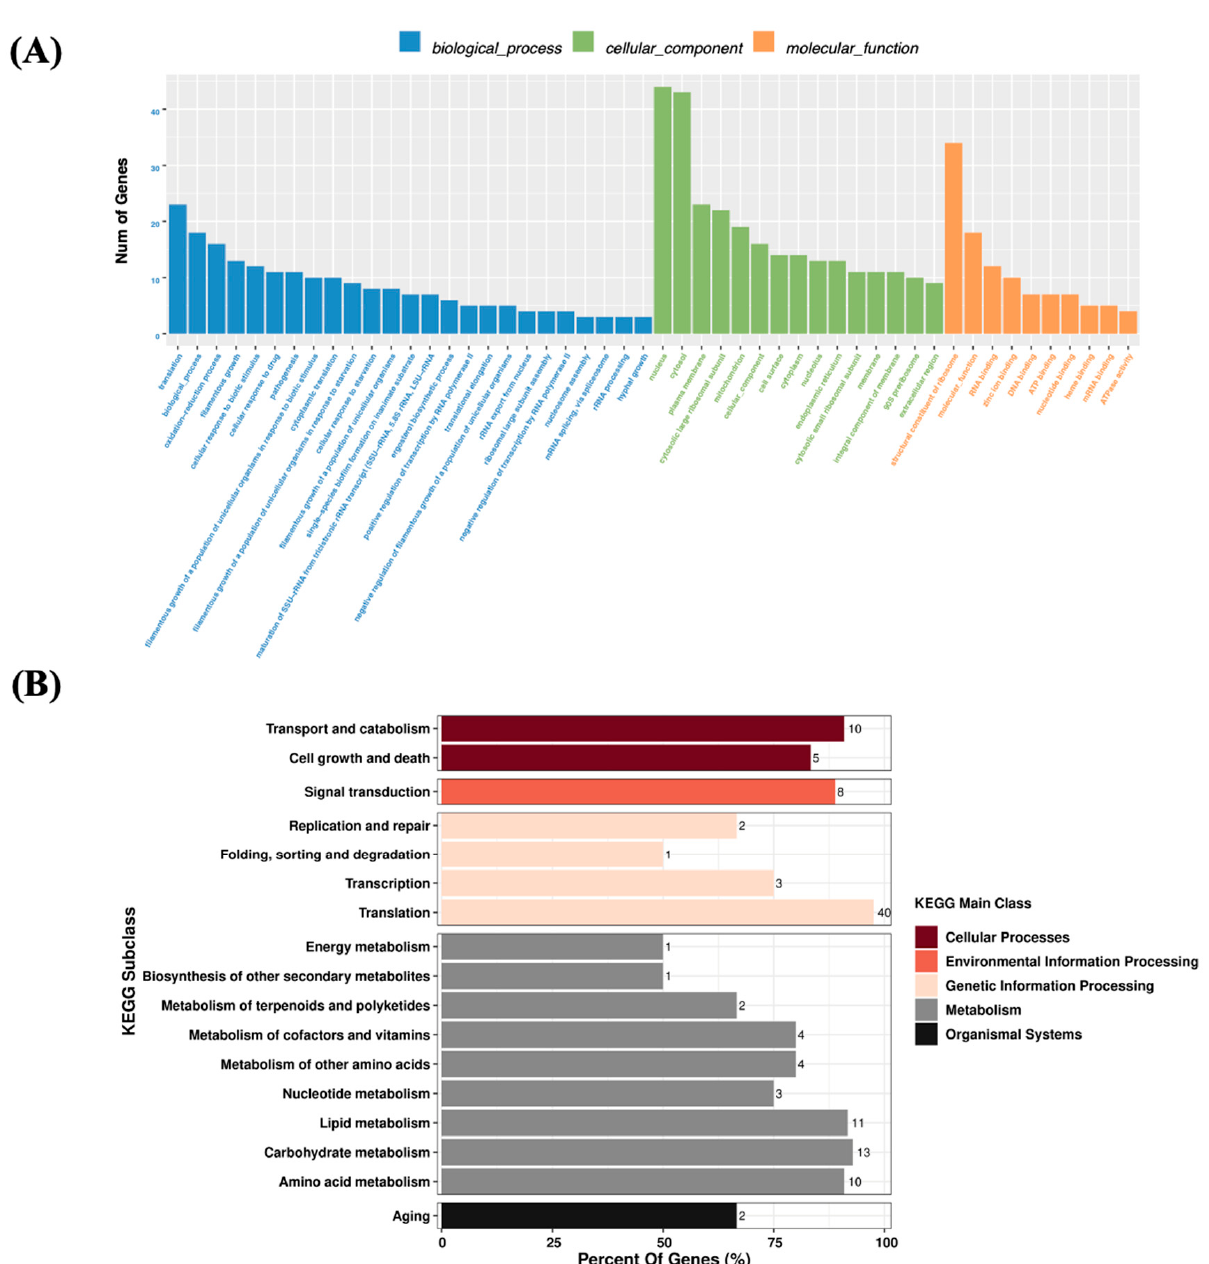
Figure 6. GO ( A ) and KEGG ( B ) enrichment analysis of DEGs in S. spartinae W9 cultured with and without 0.1% β -glucan. The numbers behind the bars stand for the number of genes involved in the metabolism.